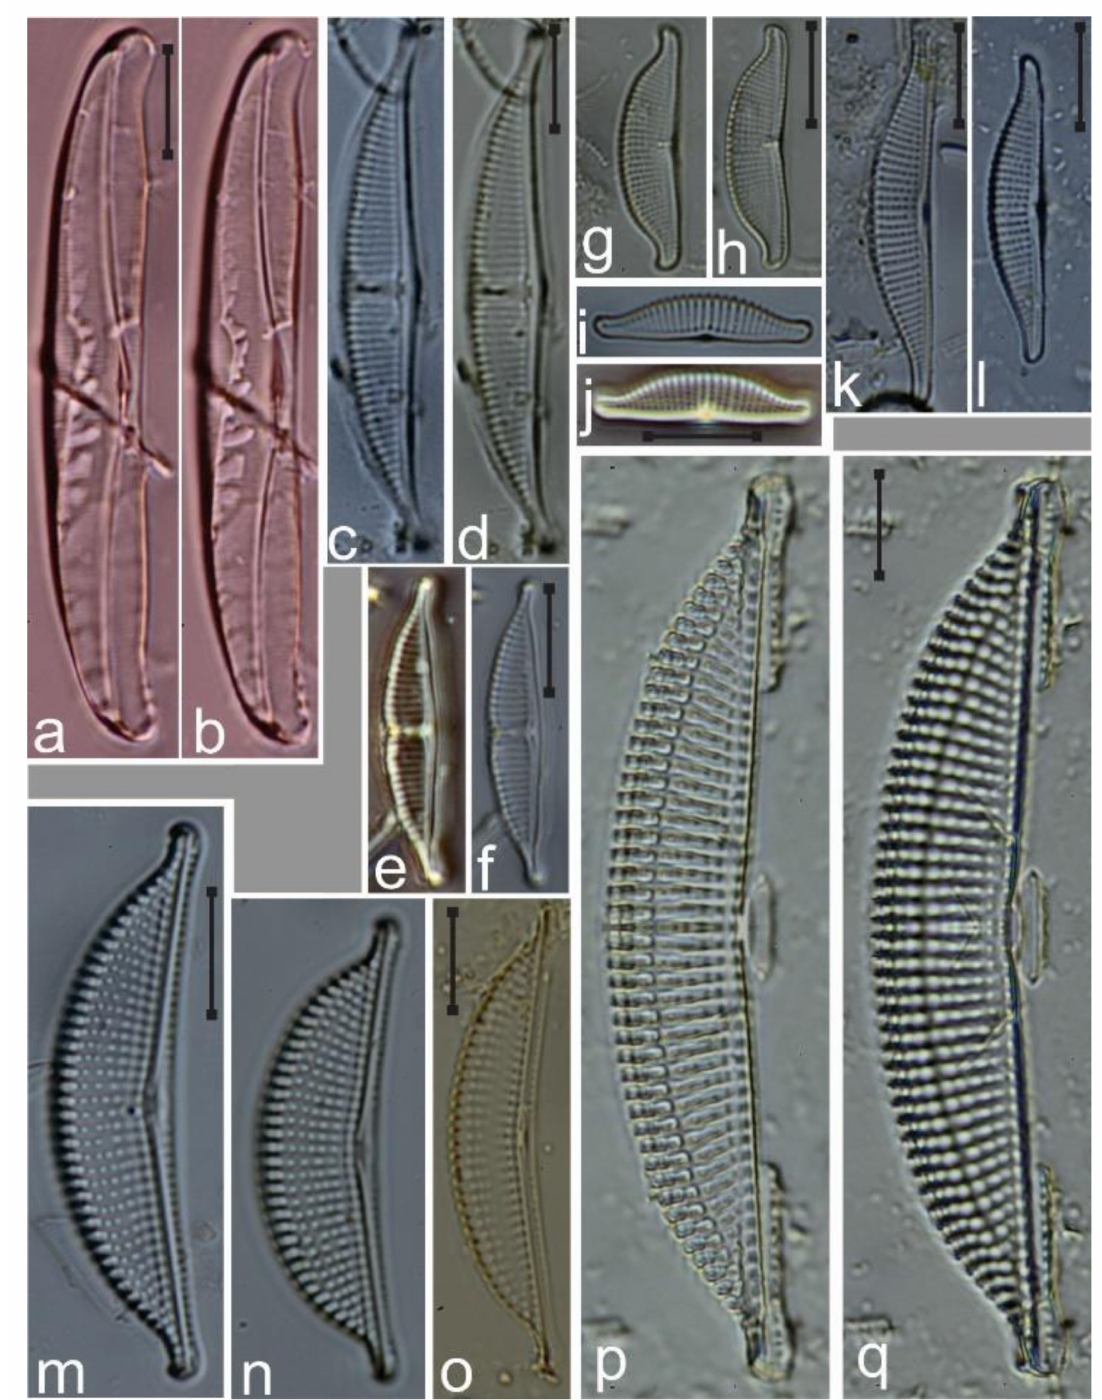
Figure 33. ( a , b ) Amphora studeri ; ( c – f ) Halamphora cuneata ; ( g – l ) Amphora angustissima ; ( m – q ) Halamphora costata . Scale bar = 10 µ